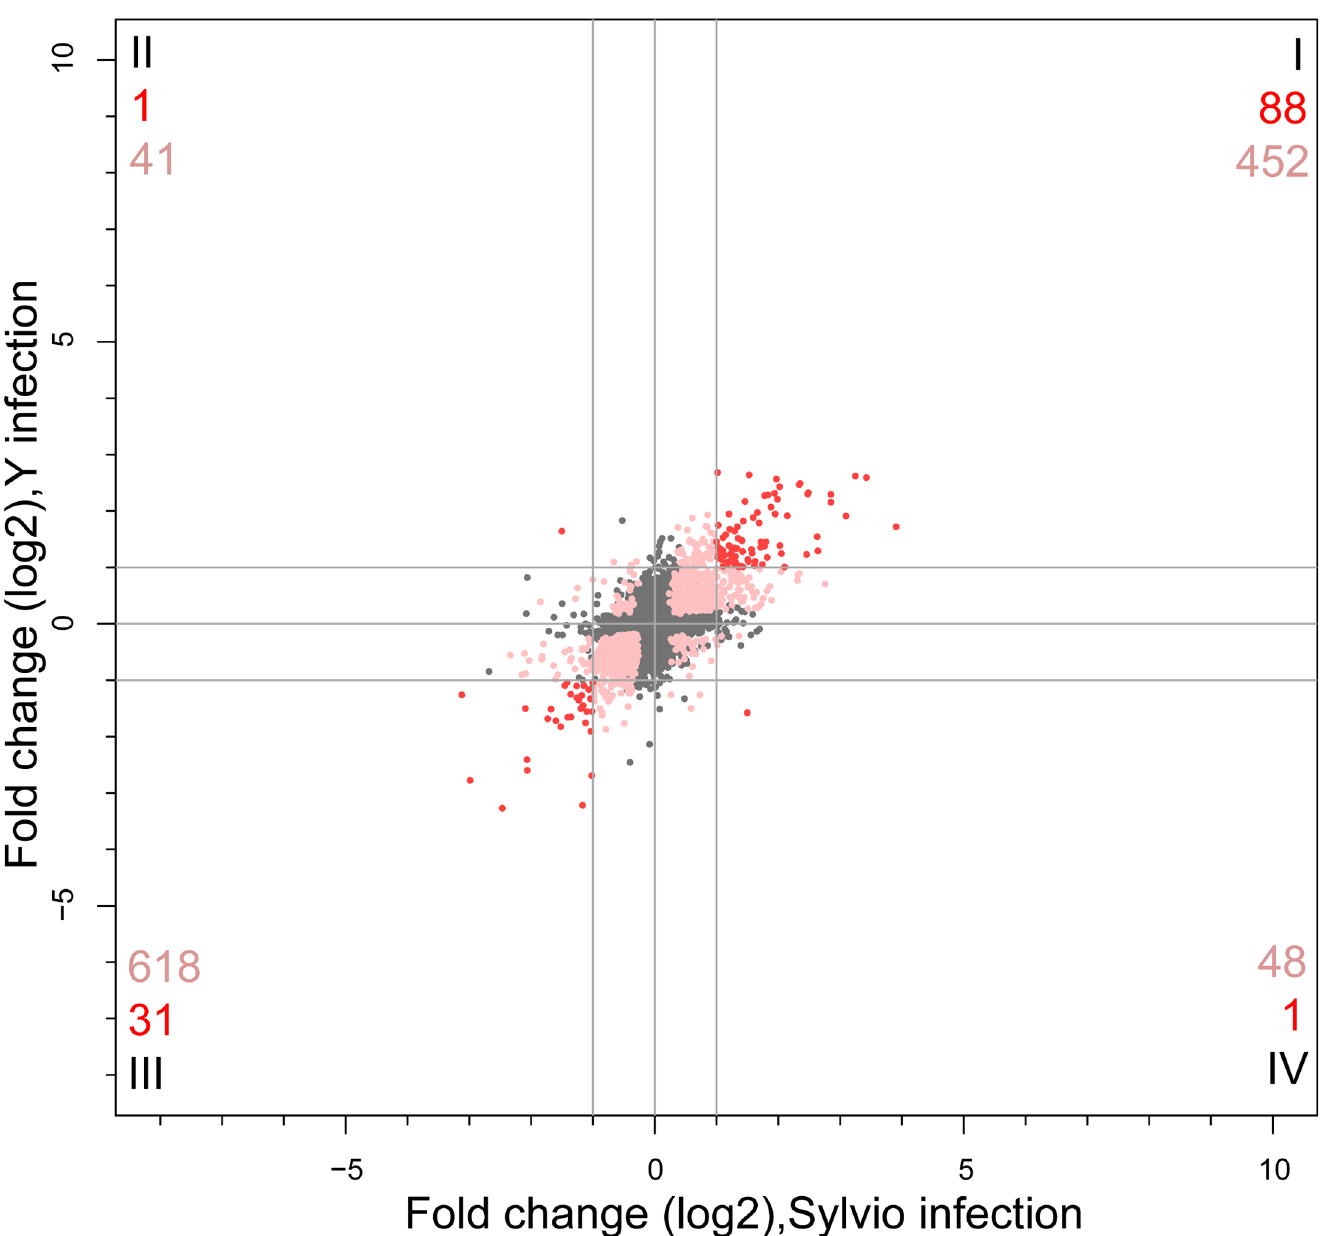
Fig 4. Comparative analysis of T . cruzi parasite Sylvio versus Y strain transcriptome response. Scatterplot of log 2 fold change in expression of a subset of orthologous T . cruzi parasite genes in Sylvio (x-axis) versus Y strain (y-axis) at 24 hpi versus 4 hpi. Genes that were not significantly differentially expressed are shown as gray dots. Pink dots represent genes that were significantly DE in both strains of parasite but had log 2 FC in one or both strains that was below our cutoff value of 1. Red dots depict genes that were significantly DE and had absolute value of log 2 FC > 1 in both strains. The numbers in each quadrant correspond to the total number of significantly DE genes that met the log 2 FC cutoff of 1 (red) or were significantly DE but did not meet the FC cutoff (pink).